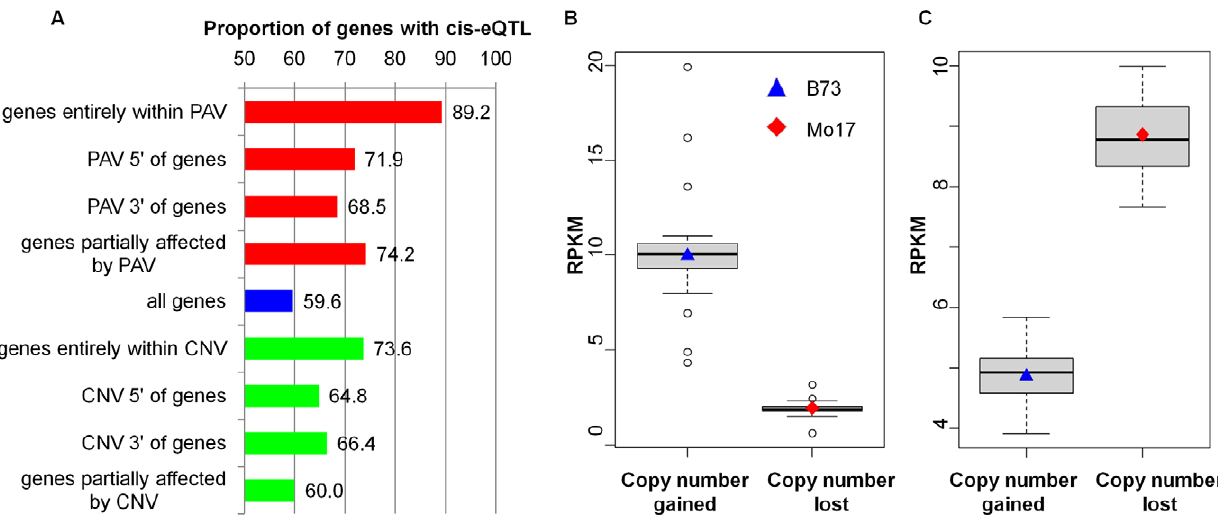
Figure 4. eQTL with CNV/PAV nearby and the influence of CNV/PAV on transcriptome variation. (A) The proportion of genes with cis- eQTL detected. Genes located within/near structural variants are enriched for cis- eQTLs, especially for genes entirely within CNV/PAV. (B) The expression distribution in the RILs of gene GRMZM2G016150 , which is entirely a CNV event, is positively correlated ( P =3.7E-46) to increased copy number at this locus in the RILs. (C) The expression distribution in the RILs of gene GRMZM2G024775 , which exhibits a gain of a copy in B73 and lines containing the B73 allele, shows a negative correlation ( P =6.3E-61) between the gain of a copy in B73 and the lower copies in Mo17. In (B) and (C), the x-axis represents the genotype of RILs for the specific gene, while the y-axis indicates the normalized expression levels in the RILs and their parents.